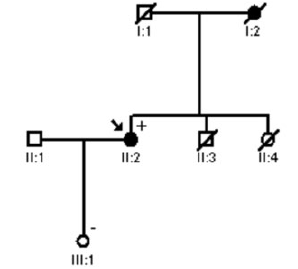
Figure 2. Pedigree of the family affected with the Arg166Pro LMNA mutation. Circles represent women; squares men, black-filled symbols represent clinically affected; plus sign, presence of the Arg166Pro LMNA mutation; minus sign, absence of the